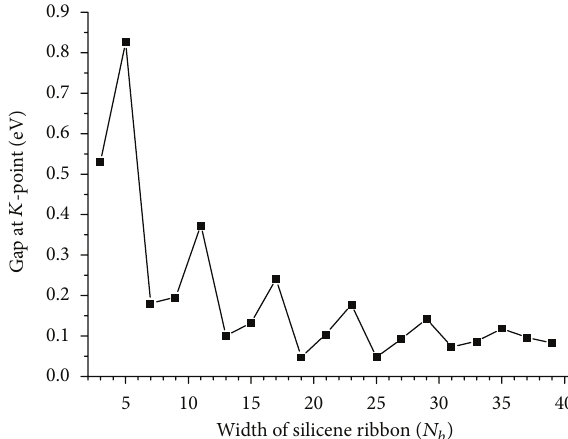
Figure 2: Dependence of calculated gap of silicone nanoribbons as a function of ribbon width 𝑟𝑤 = 𝑁 𝑏 𝑎 ⋅ √3/2 for fixed ribbon length 𝑎 . Parameters of the ribbons are 𝑁 𝑟𝑙 = 𝑁 𝑎 lattice constant 𝑎 = 3.933